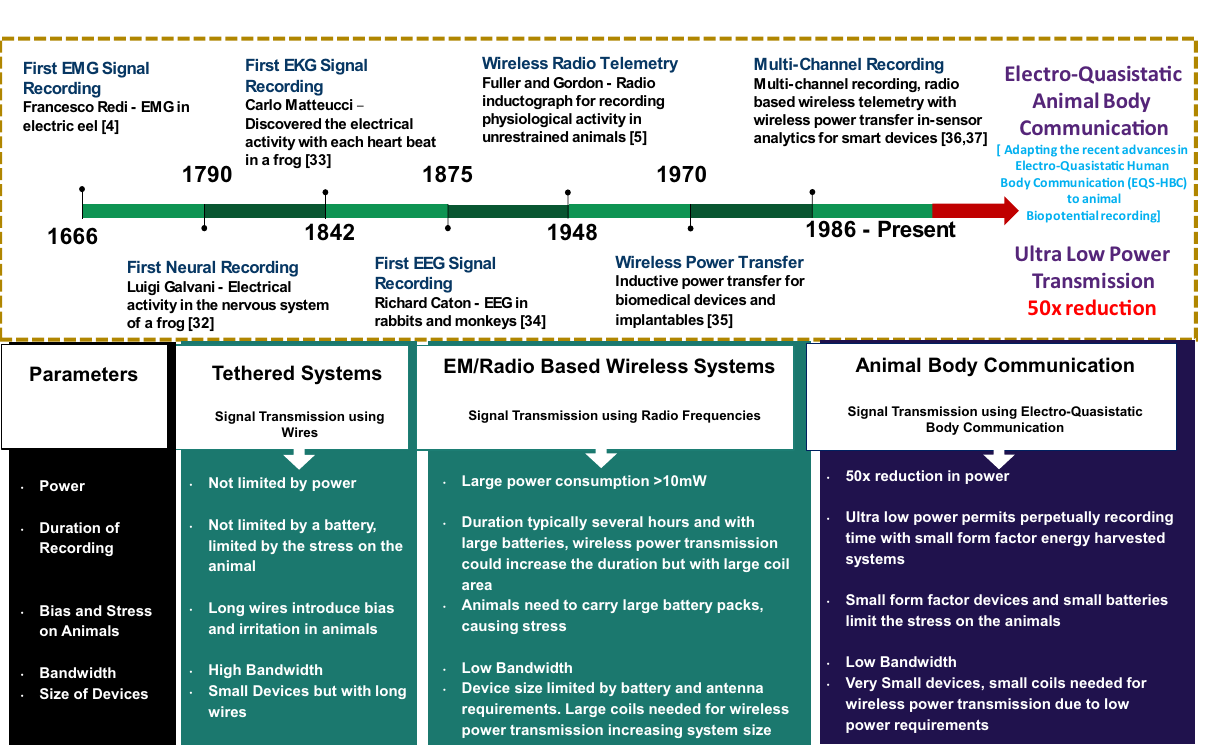
Figure 9. Evolution of animal biopotential recordings 5,6,37–42 ; Comparison of tethered, traditional wireless systems and Animal Body